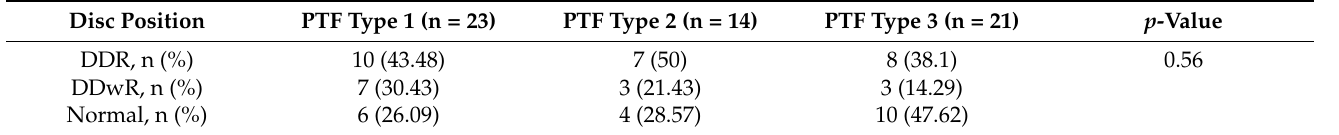
Table 1. PTF type in TMD patients according to disc position.